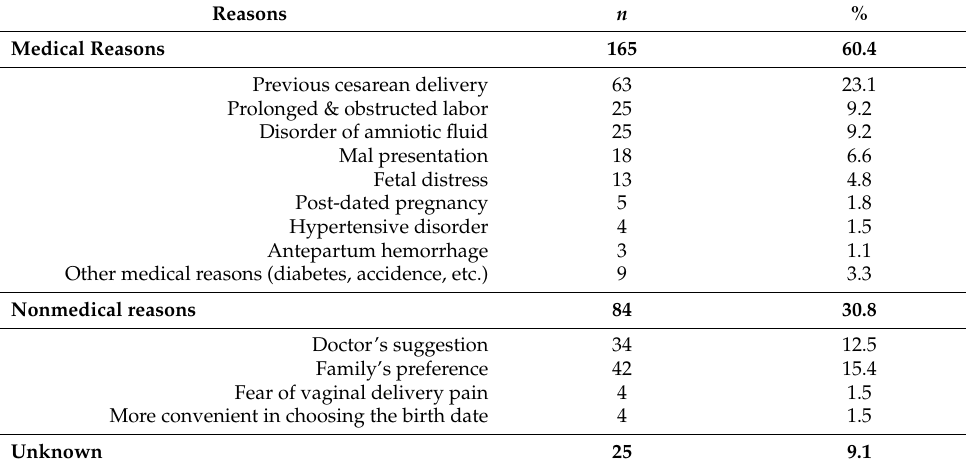
Table 1. The main reason for having cesarean delivery ( n =